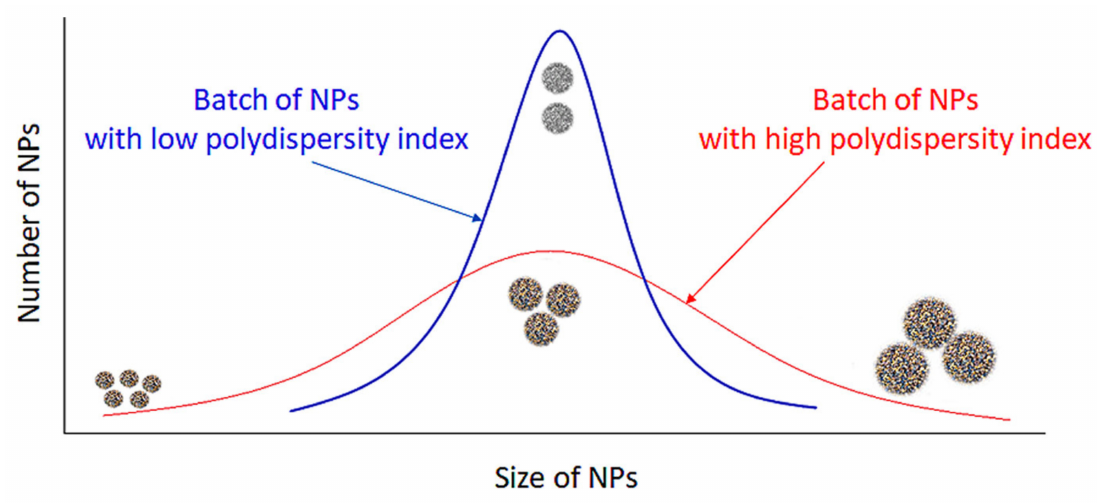
Figure 6. Influence of PDI on homogeneity of PC. A low PDI indicates that the NP solution is homogenous, while a high PDI indicates that a solution is more